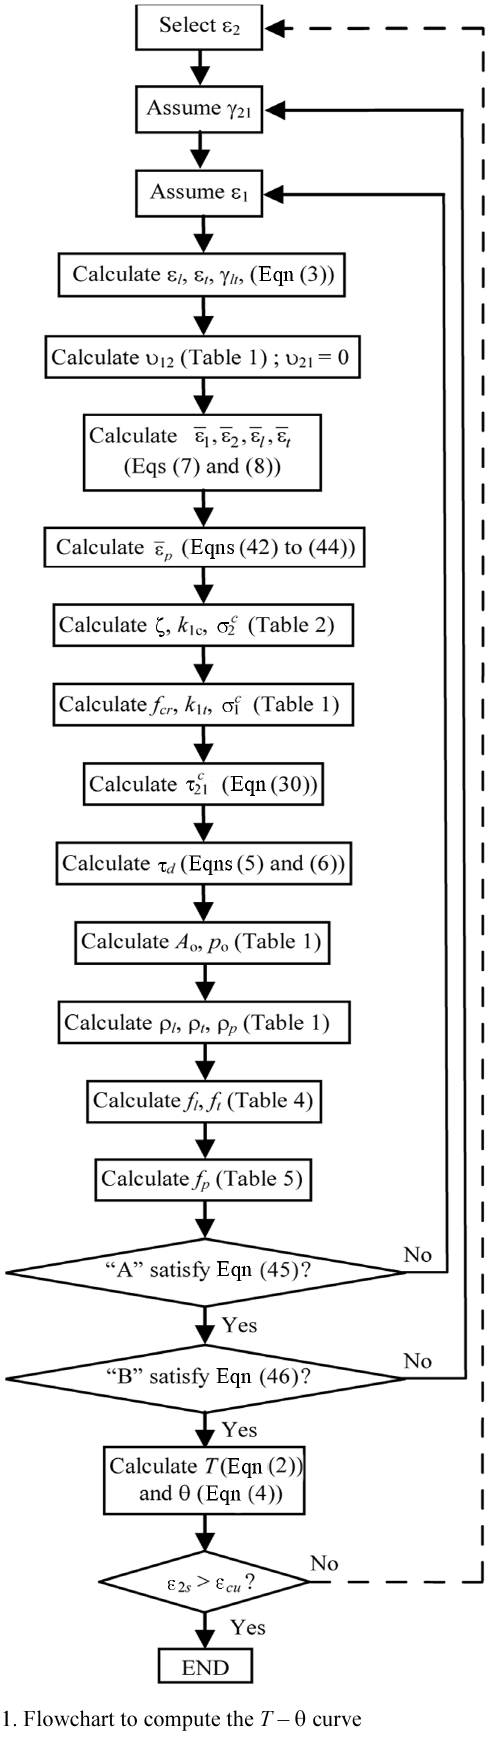
Fig. 1. Flowchart to compute the T – θ curve